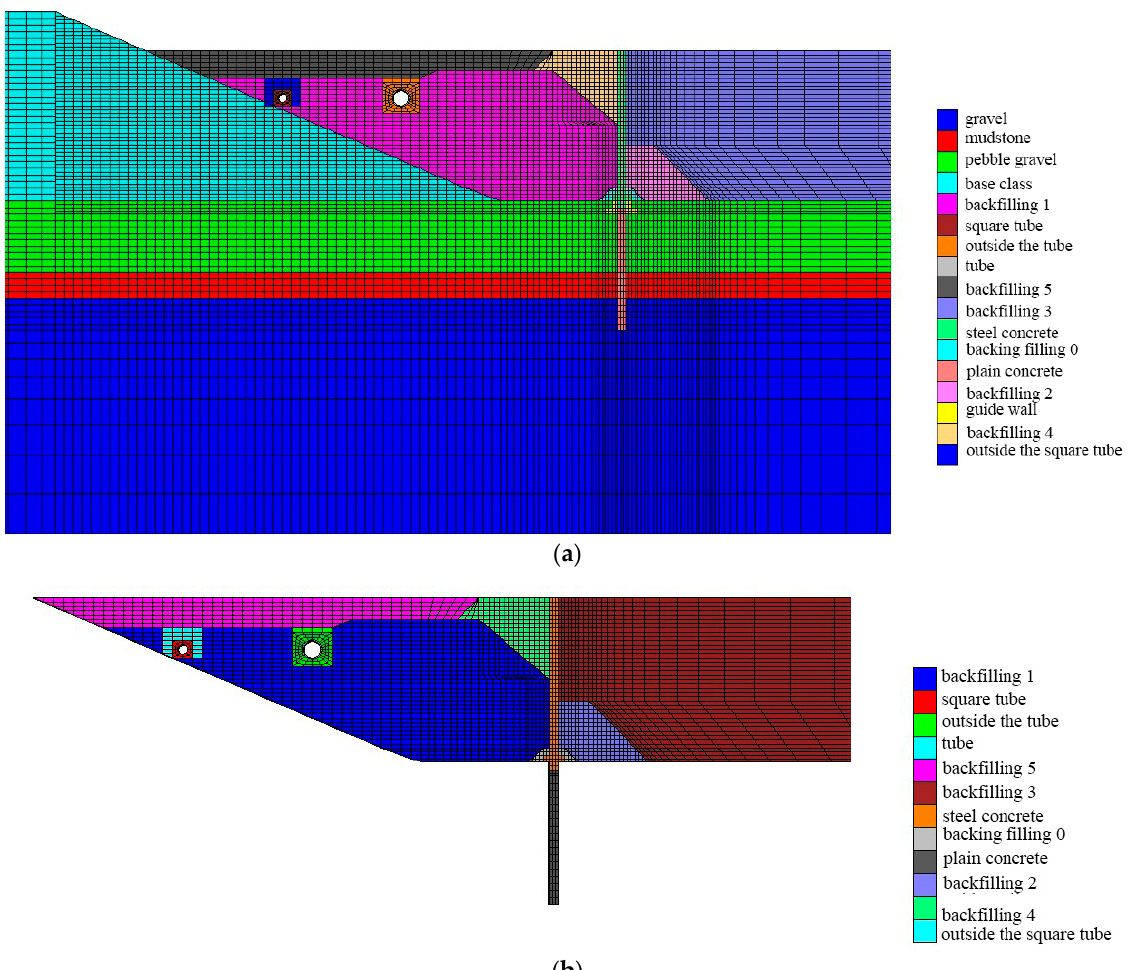
Figure 4. Monitoring 1, 2 section model. ( a ) Grid division of monitoring section model 1 and 2. ( b ) Monitoring the relationship between the backfill soil and cut-off wall at sections 1 and 2.